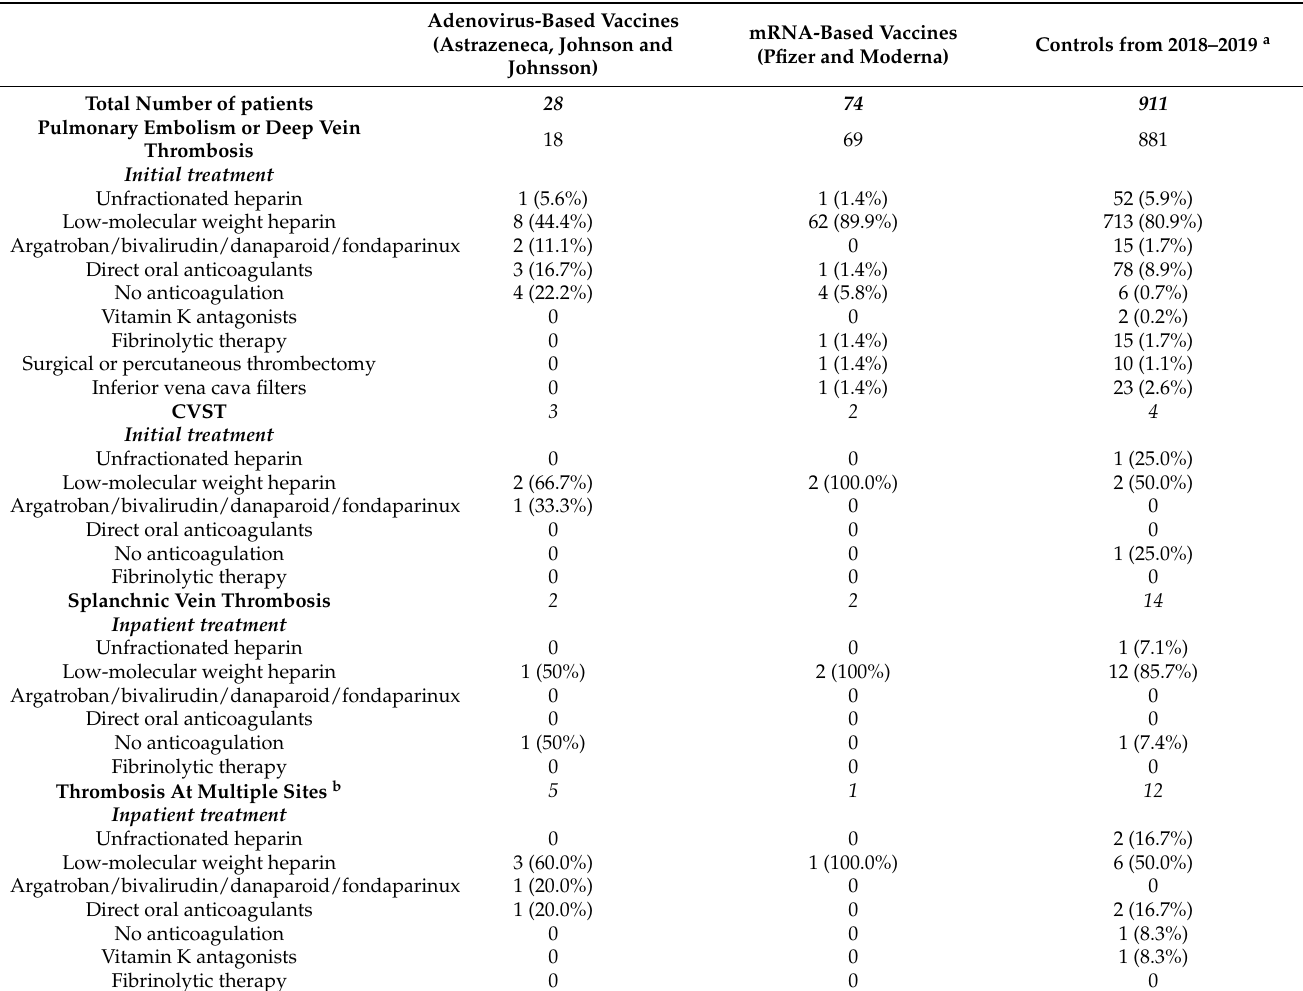
Table 2. Treatment